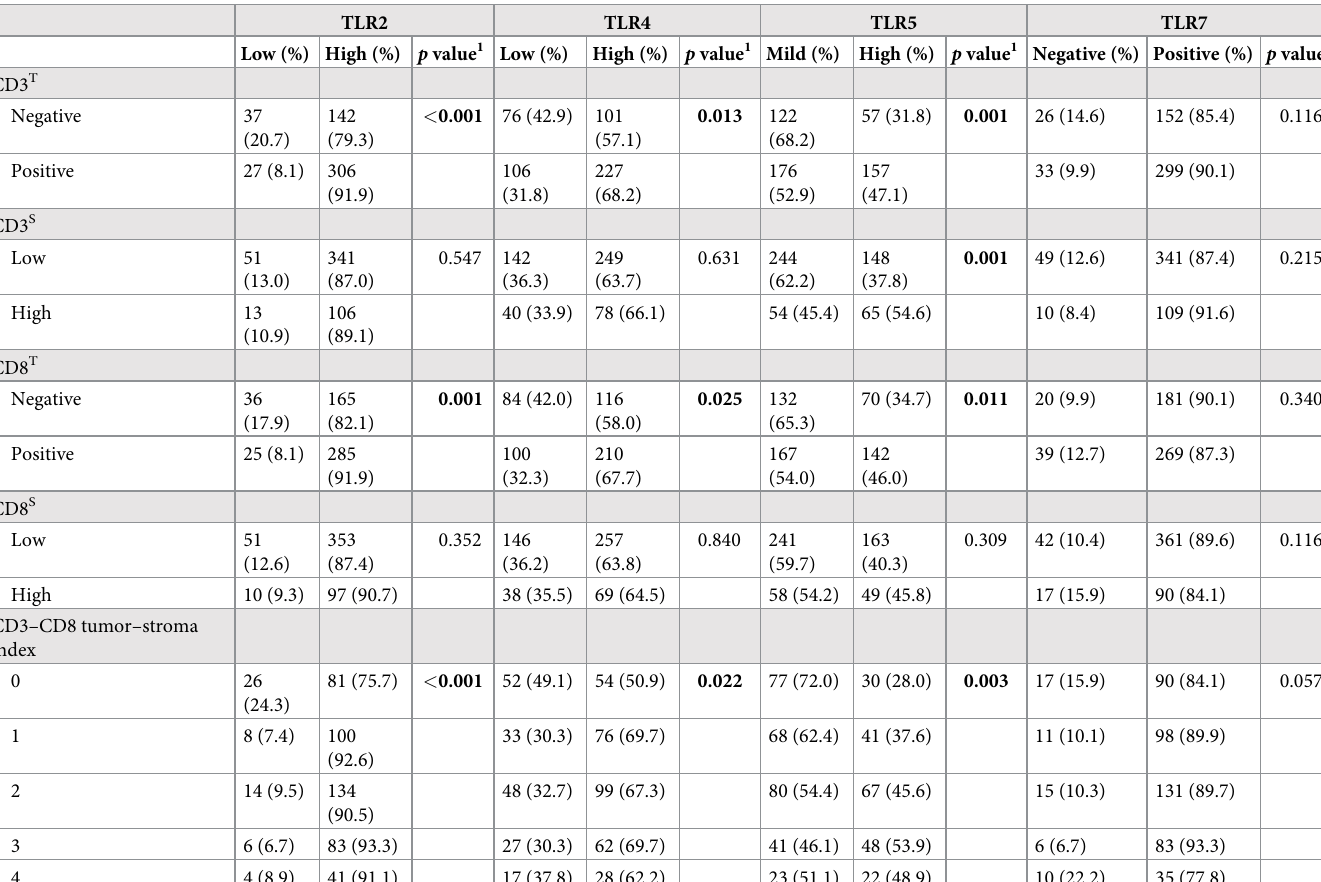
Table 1. Associations between the immunoexpressions of TLRs and the tumoral and stromal densities of CD3 and CD8 cells and CD3–CD8 tumor–stroma index in 549 CRC patients. TLR2 TLR4 TLR5